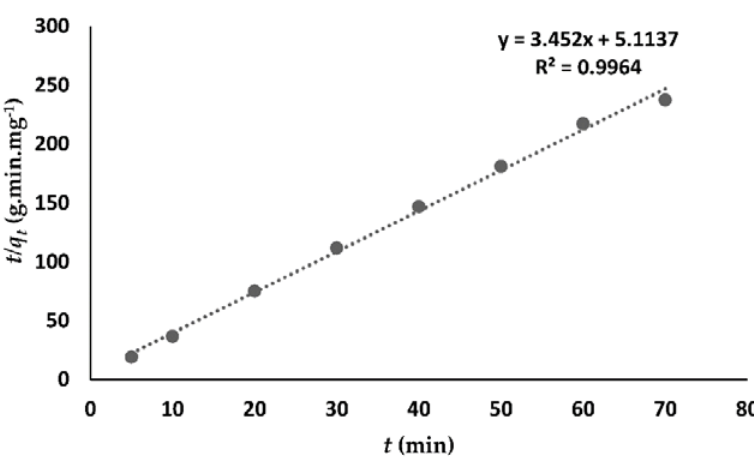
Figure 13. Pseudo-second-order reaction of HDTMA-VMT 0.2M . Table 3. Parameters for pseudo-first-order and pseudo-second-order kinetic